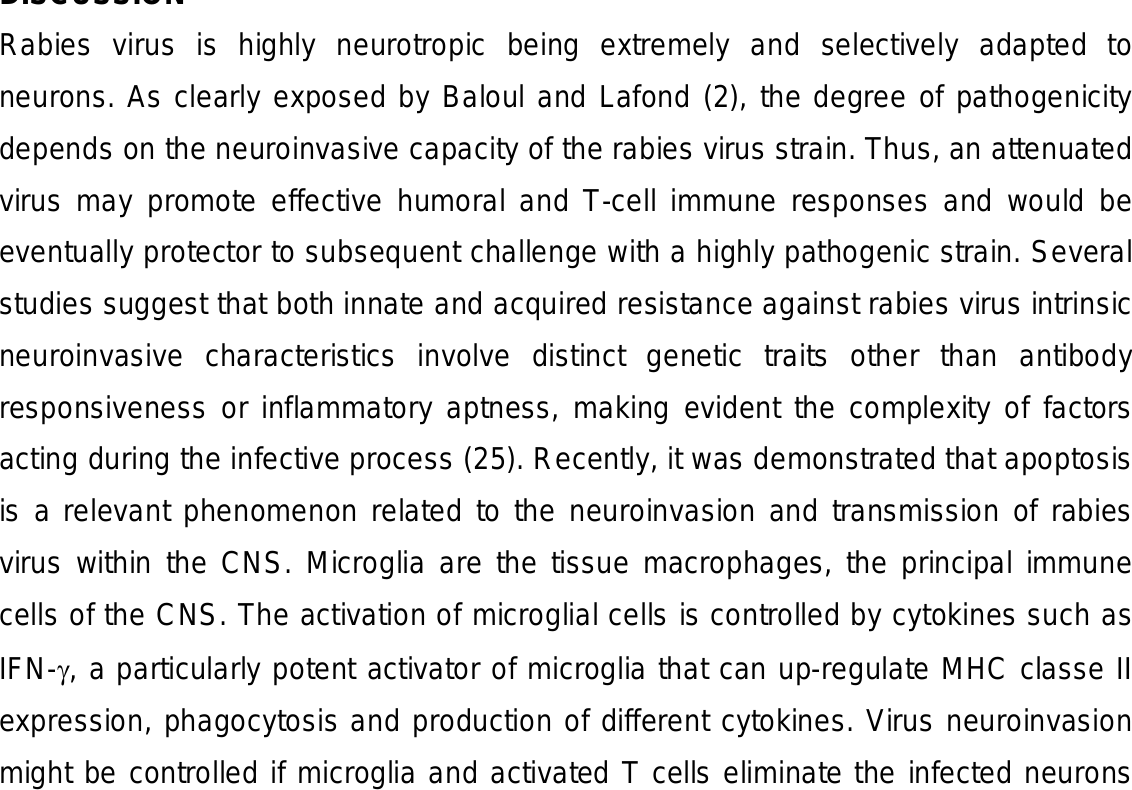
ANTIBODY ISOTYPE PROFILE IN GENETICALLY MODIFIED MICE. J. Venom. Anim. Toxins incl. Trop. Dis